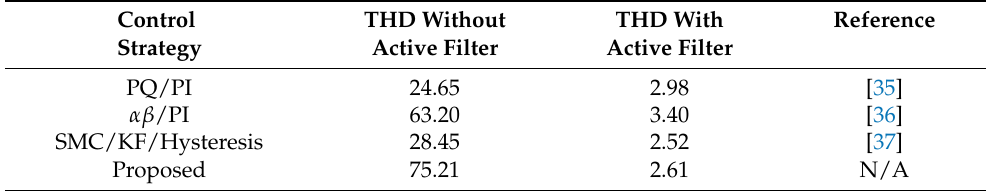
Table 3. Results